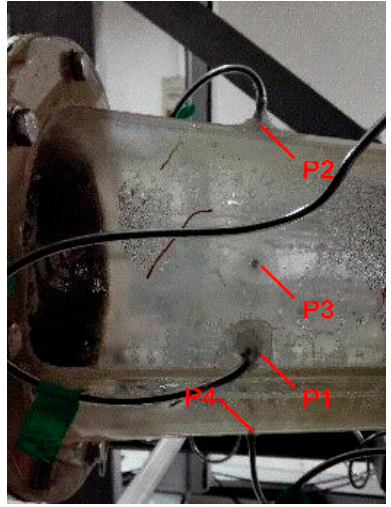
Figure 9. Installation positions of pressure sensor.